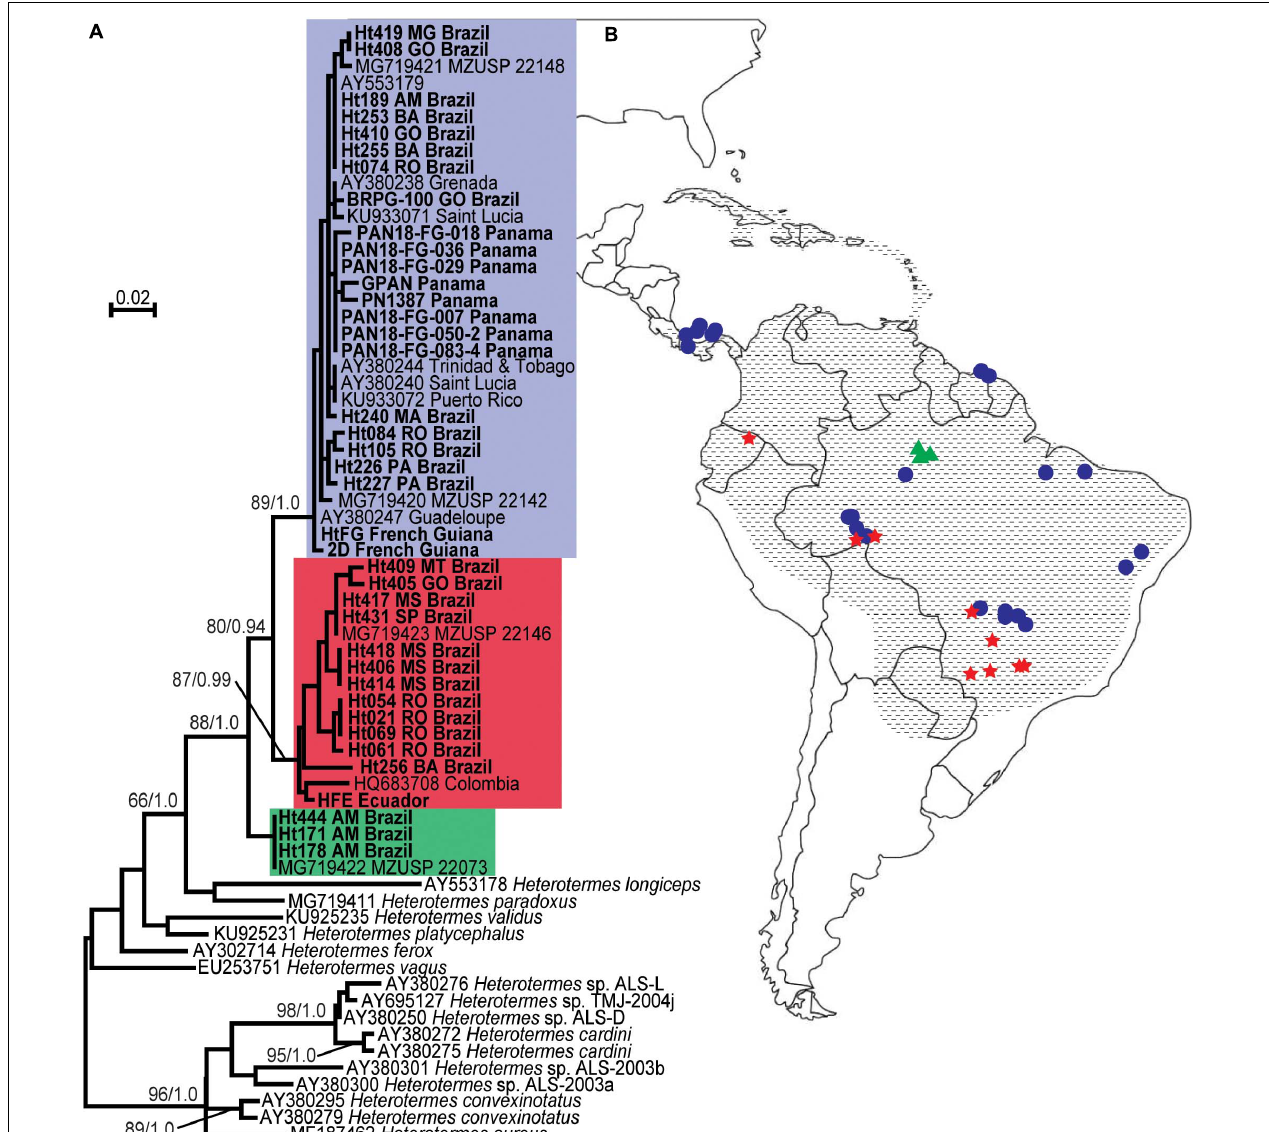
FIGURE 5 | Collection locations and molecular identification of Heterotermes tenuis colonies. (A) Maximum likelihood phylogeny of Heterotermes partial mt16S gene sequences. Heterotermes tenuis sequences are indicated by colored boxes (top box is blue, middle is red, bottom is green); new sequences determined in this study are indicated by bold type. Support at nodes is given from 100 bootstrap replicates and Bayesian posterior probabilities where greater than 60/0.9. (B) Collection locations of H. tenuis colonies. Shapes indicate collection locations of samples included in this study, with color corresponding to the same haplotype group color scheme as in (A) (top blue haplotype = circles, middle red haplotype = stars, bottom green haplotype = triangles). Hatching indicates the geographical range of H. tenuis (Carrijo et al.,